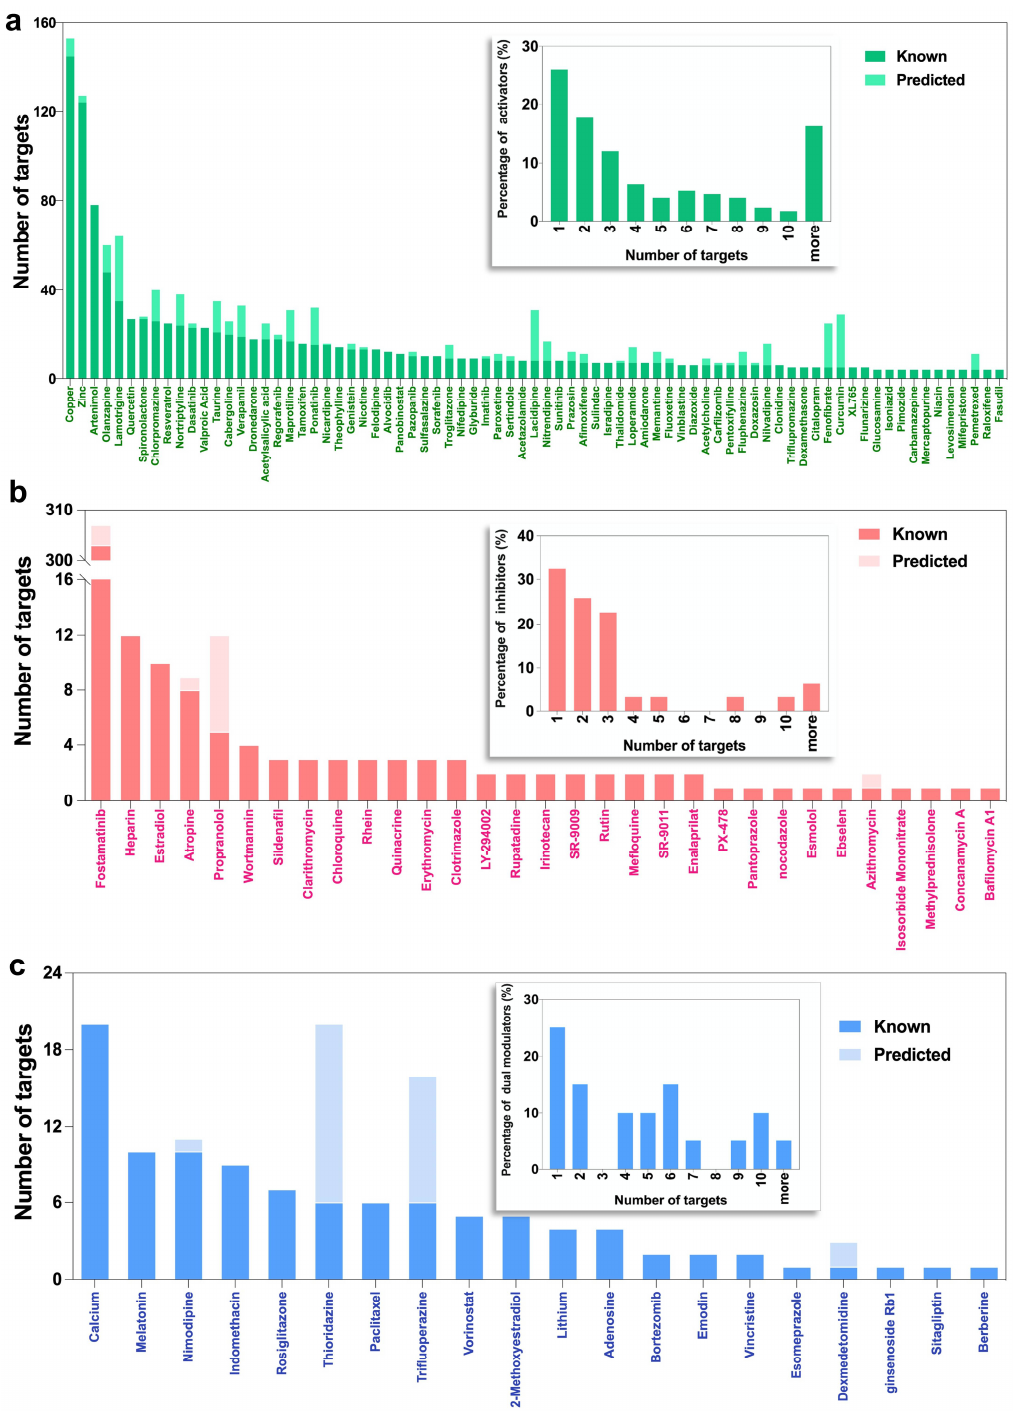
Figure 2. Promiscuity of autophagy modulators. ( a ) The number of known and predicted targets of activators; ( b ) The number of known and predicted targets of inhibitors; ( c ) The number of known and predicted targets of dual-modulators. The drugs are ranked in a descending order of the number of known targets. The contributions of the known and predicted drugs to the total number of targets are shown by the dark and light colors as indicated by the labels. See also Figure S3 for additional data on activators. Insets: Percent distribution of modulators vis-à-vis their promiscuity. The promiscuity is quantified by the degree of each modulator, i.e., the number of targets ( abscissas ) associated with the